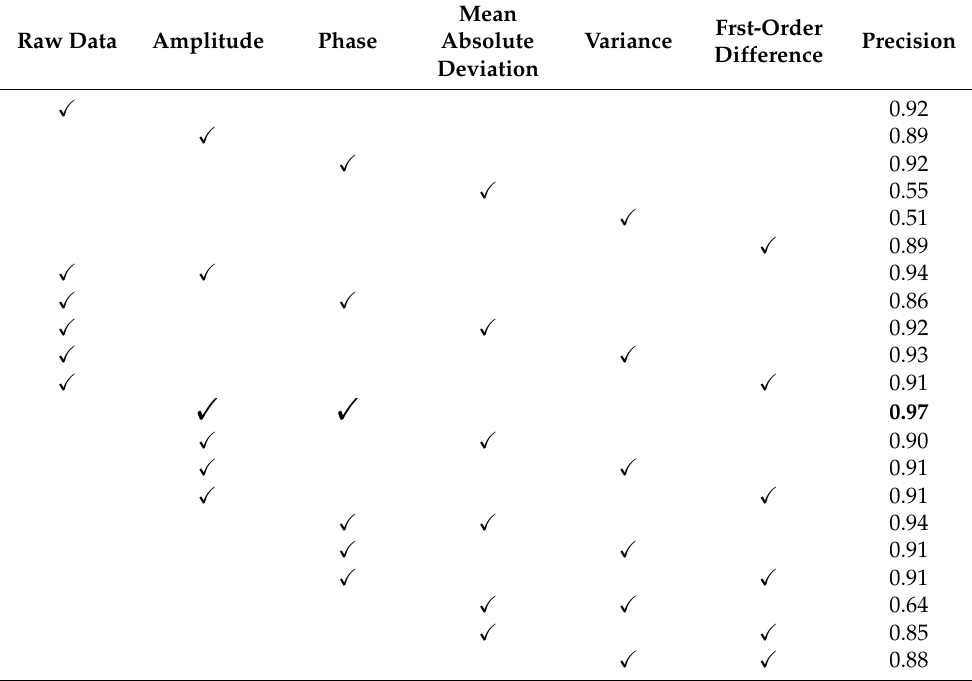
Figure 4. The signal ratio of the two receiving antennas. Table 2. Recognition effects of different features and